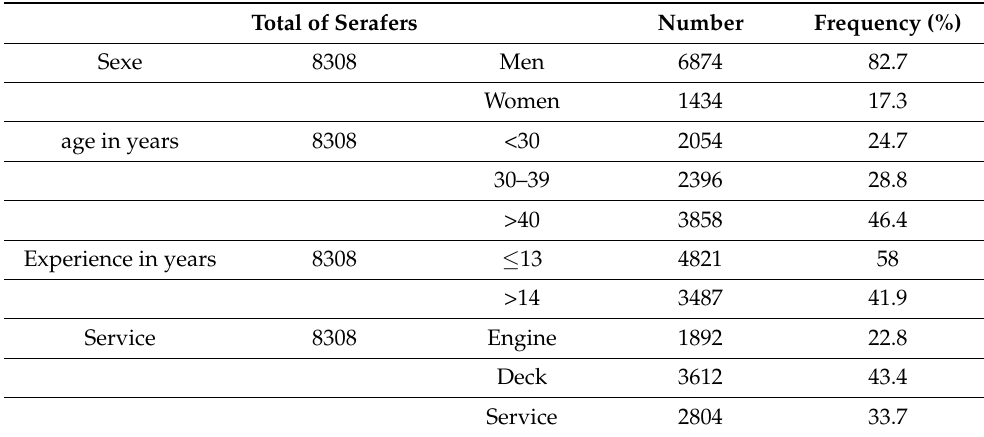
Table 1. Demographic characteristics of included population.